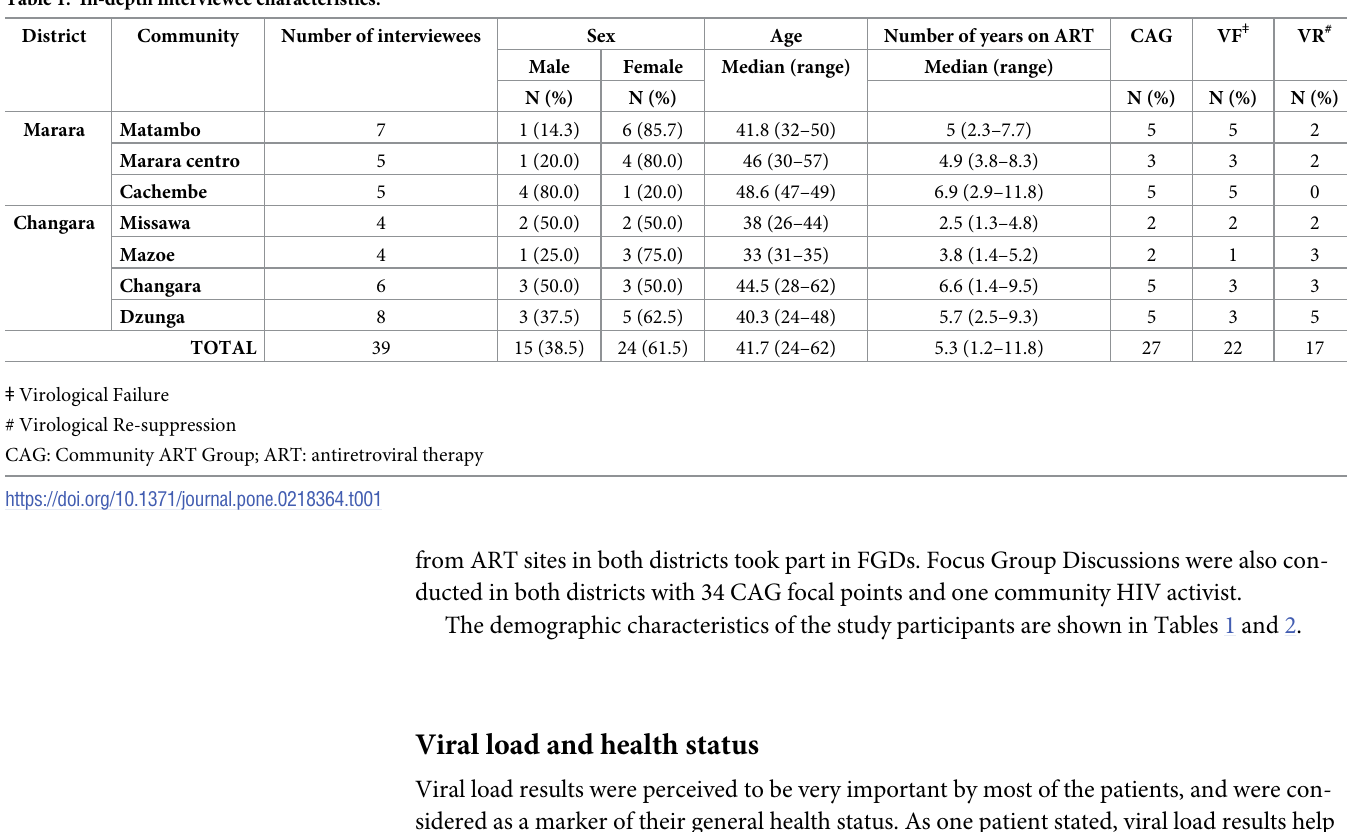
Table 1. In-depth interviewee characteristics.